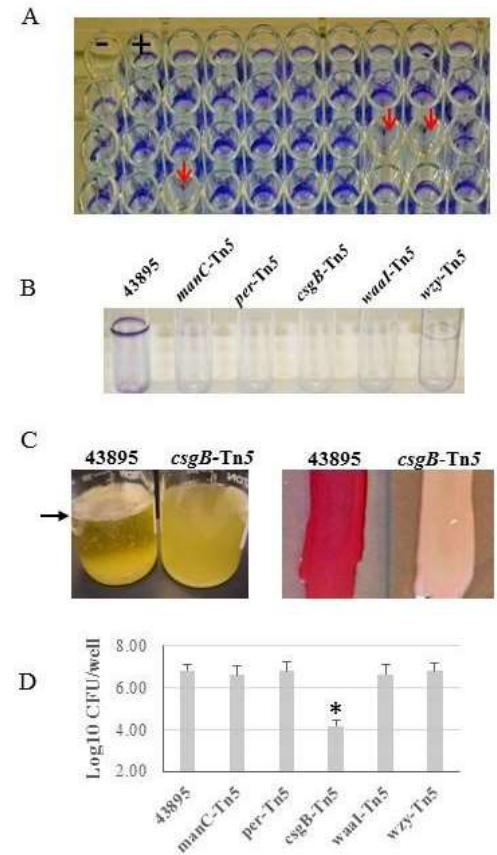
Figure 1. O157 mutants lose biofilm, Congo red binding, and epithelial cell invasion ability . ( A ) A Tn 5 insertion library of O157 strain 43895 (43895) was generated and screened using a crystal violet assay at 30 ◦ C. A representative microtiter plate with Tn 5 mutants is shown with control strains 43894 (biofilm-negative, -) and 43895 (parental biofilm-positive, + ); arrows indicate wells with biofilm-negative mutants. ( B ) Biofilm-negative mutants were confirmed by a static crystal violet tube assay at 37 ◦ C as compared to the 43895 biofilm-positive control strain. Disrupted genes were identified by sequencing across the Tn 5 -insertion junction as manC , per , csgB , waaI , and wzy . ( C ) The csgB ::Tn 5 mutant and the 43895 control strain were grown at 37 ◦ C in Luria-Bertani (LB) broth without aeration to assess pellicle formation or on Congo red indicator agar to assess dye-binding. csgB ::Tn 5 did not form a pellicle (left) at the air-liquid interface (arrow) and had reduced Congo red dye-binding (right). ( D ) Epithelial cell invasion was measured by a gentamicin protection assay. Bacteria were co-cultured with bovine mammary epithelial cell line (MAC-T) monolayers (MOI = 10) and CFUs determined by plate count (triplicate experiments, three replicates / strain). Only csgB ::Tn 5 shows a ~100-fold reduction in cell invasion compared to 43895 and other biofilm-negative mutants; bars represent + SE and * denotes p < 0.05. The csgB ::Tn 5 mutant had ~10-fold reduction in adherence to MAC-T cells compared to wild type 43895 (Table 3). Table 3. Adherence to and invasion of MAC-T cells by O157 strain 43895 and its derivatives. Strains